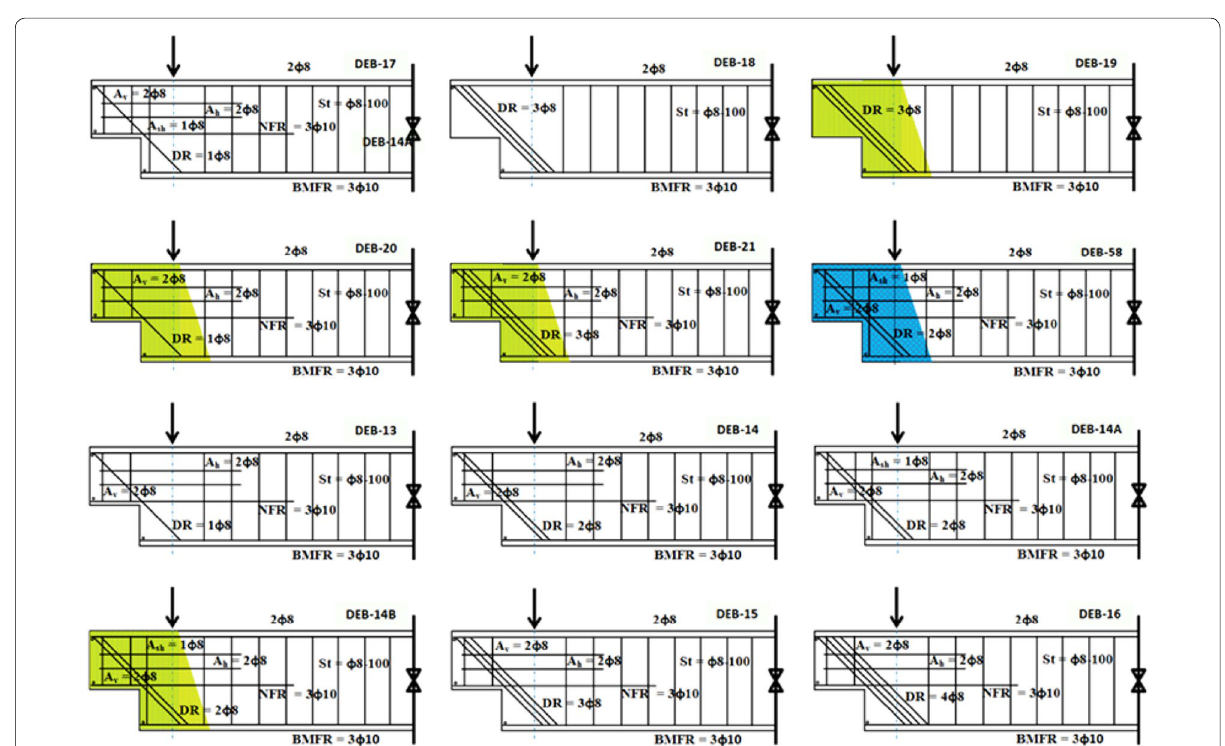
Fig. 3 The steel reinforcement configuration of DEBs in the second